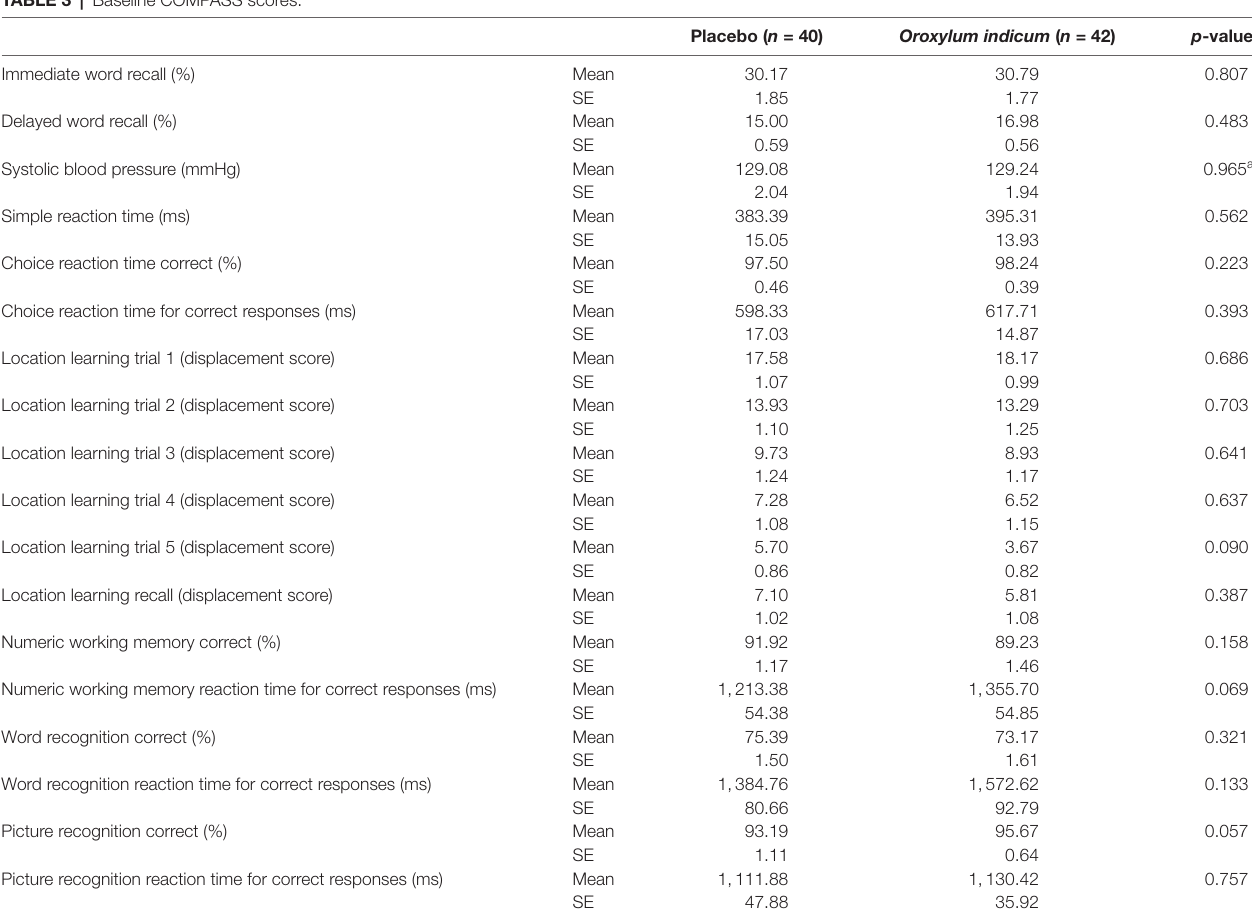
TABLE 3 | Baseline COMPASS